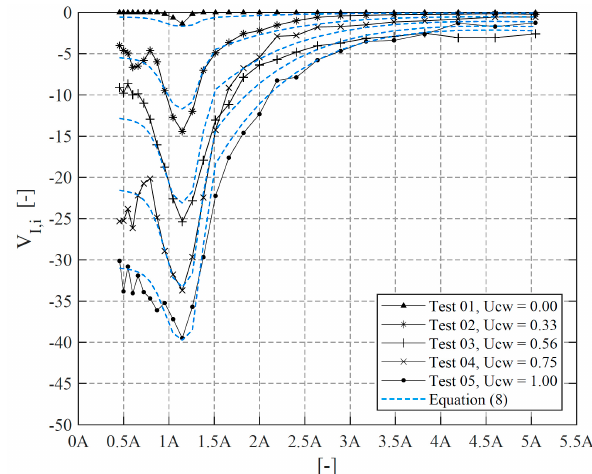
Figure 10. Incremental erosion volume V I , i (see Equation (5)) depicted over the structure footprint length A and compared with calculated values stemming from Equation (8).